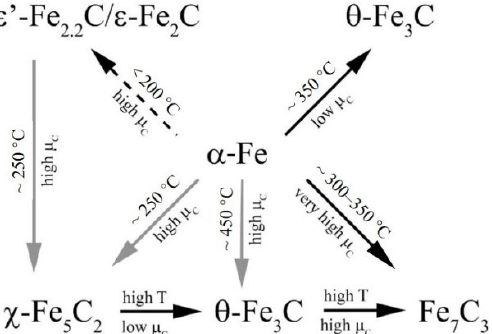
Figure 10. Qualitative interpretation of the ab initio atomistic thermodynamics study of iron carbides structures (gray arrows indicate transformations where entropic contributions to the total free energy may be significant. The dashed arrow indicates that the transformation may be kinetically inhibited). Reprinted with permission from ref. [152]. Copyright 2010 American Chemical Society.